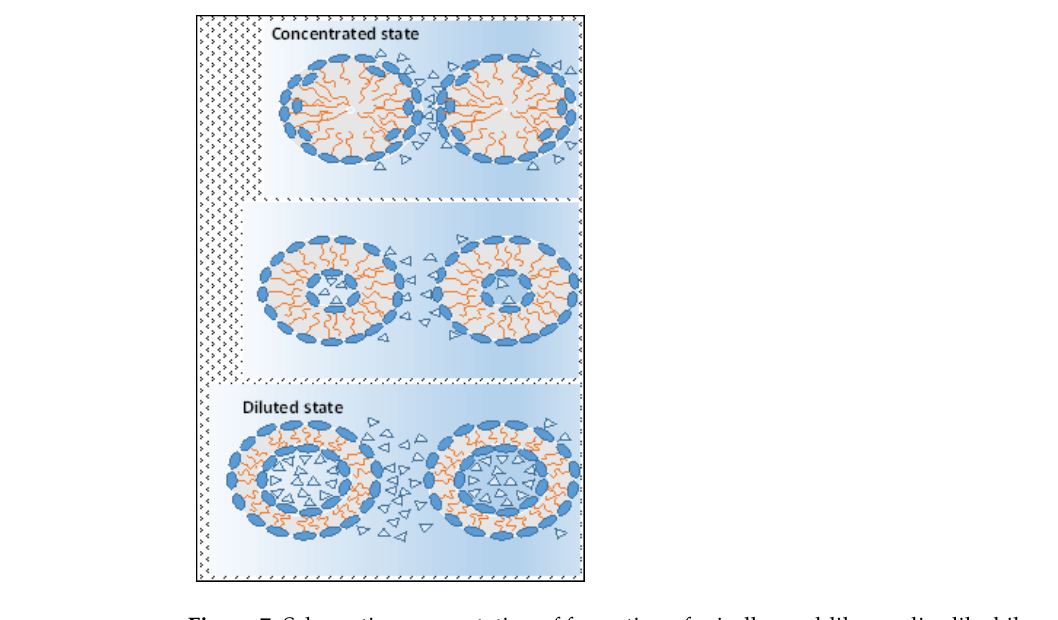
Figure 6. Schematic representation of formation of micellar, rod-like, or disc-like bilayers by pre- vailing hydro-repulsion. The symbols “ ∆ ” denominate water molecule O < HH .